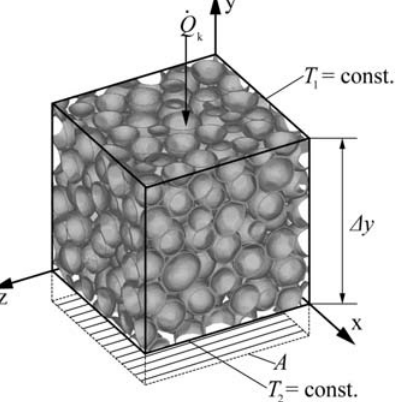
Figure 1. 3D-object of the micro-computed tomography record with applied boundary